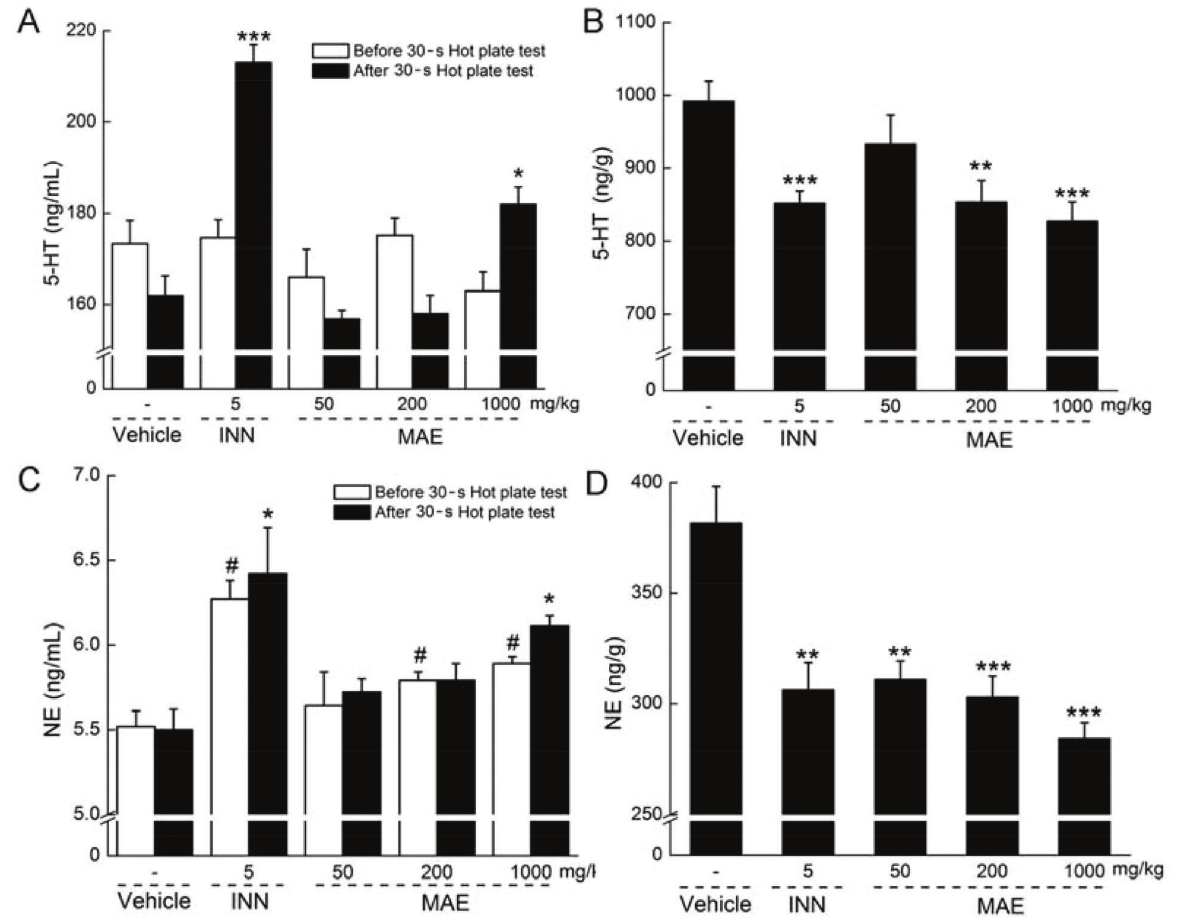
Figure 2. Mice were treated with M. androsaceus extract (MAE) (50, 200, and 1000 mg/kg) and tramadol (INN, 5 mg/kg) for 2 weeks. Before and after 30-s thermal stimulation, blood samples and hypothalamus tissues were collected, and the levels of 5-HT and norepinephrine (NE) in the serum ( A, C ) and hypothalamus ( B, D ) were analyzed using ELISA. Data are reported as means ± SE (n=10). # P o 0.05 and ### P o 0.001 vs control group (before 30-s thermal stimulation); *P o 0.05, **P o 0.01, and ***P o 0.001 vs vehicle group (after 30-s thermal stimulation) (one-way ANOVA followed by Dunn ’ s